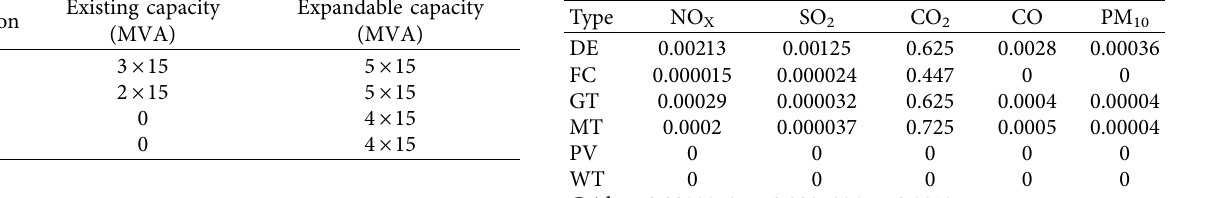
Table 6: Specification of the distribution transformers.